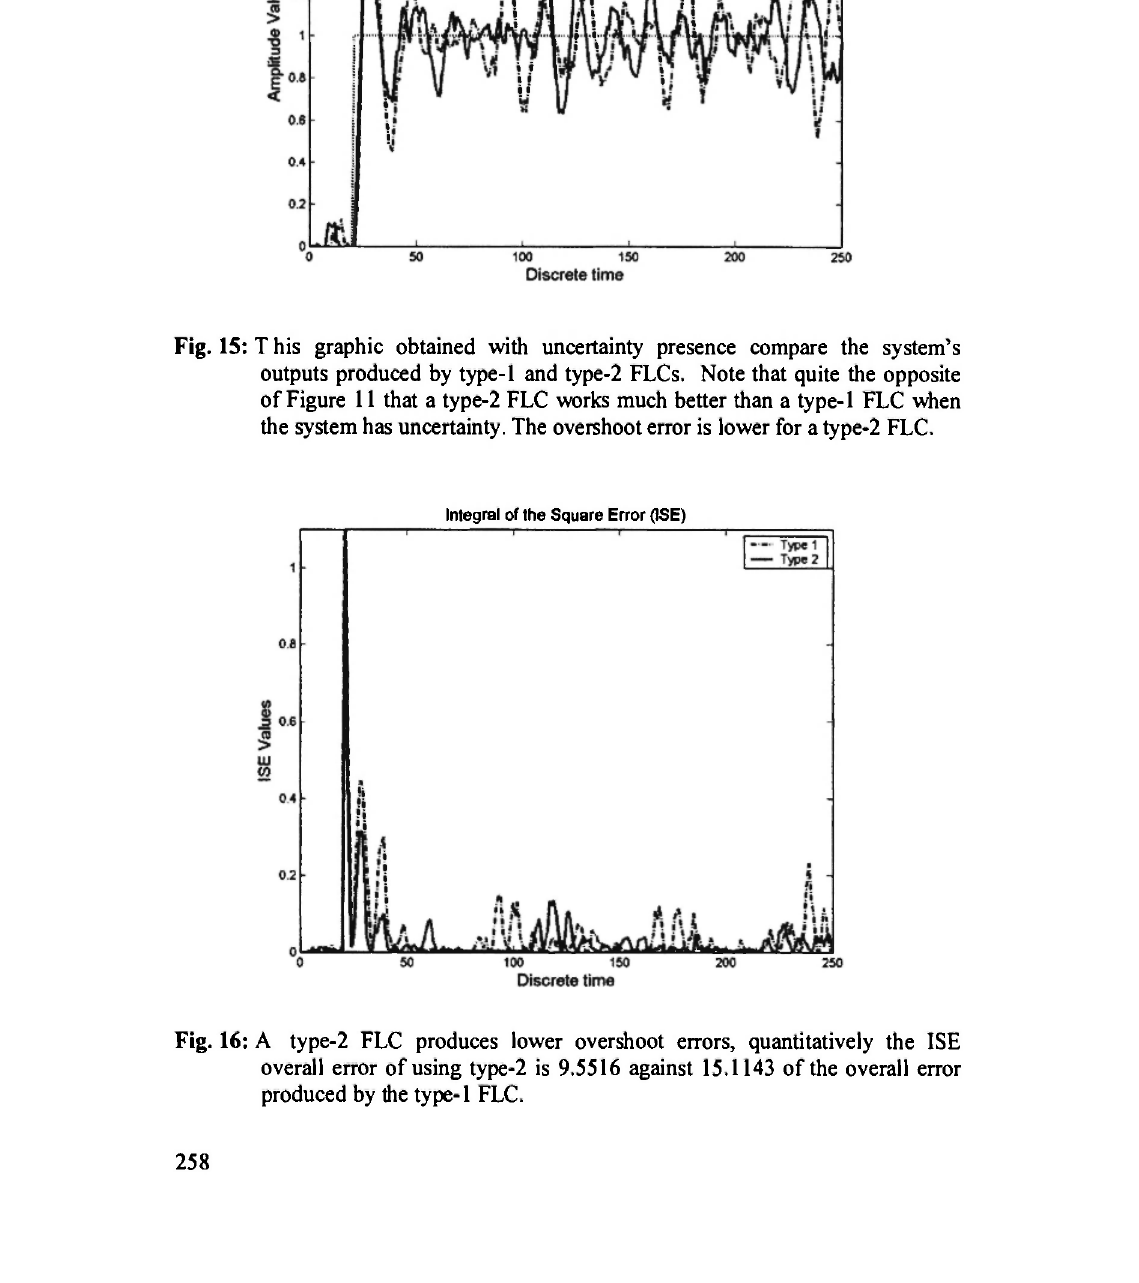
Fig. 16: A type-2 FLC produces lower overshoot errors, quantitatively the ISE overall error of using type-2 is 9.5516 against 15.1143 of the overall error produced by the type-1